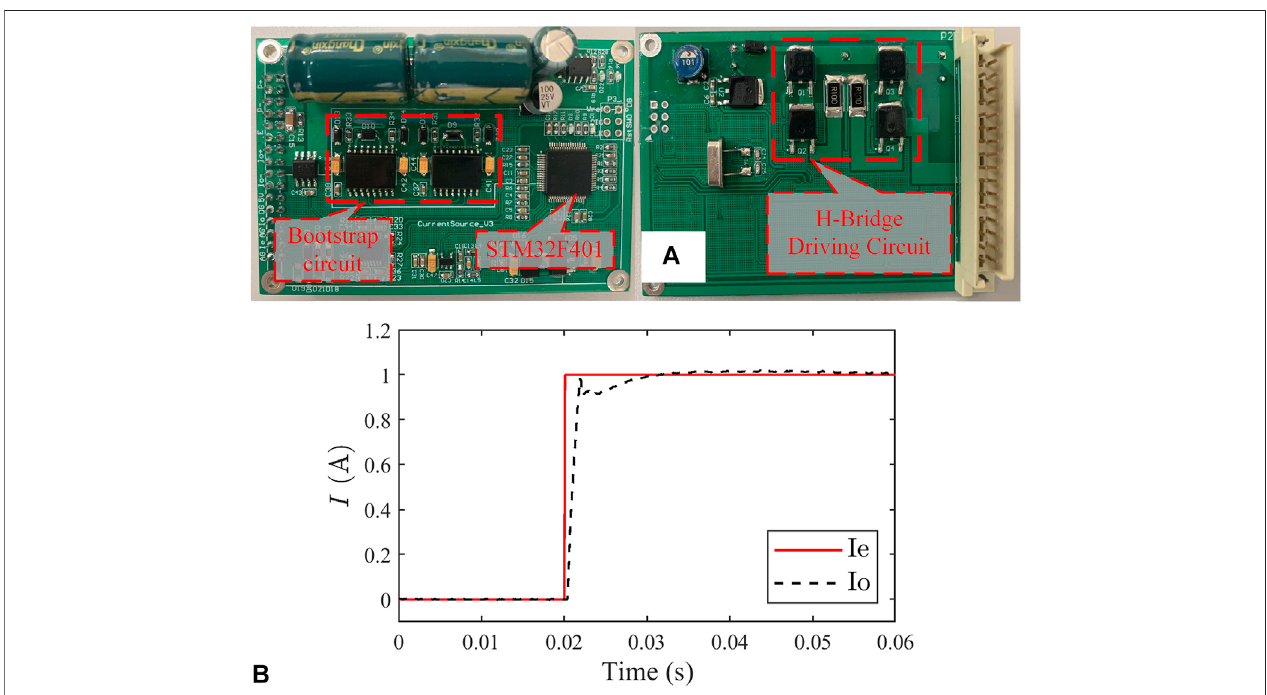
FIGURE 2 | Current driver: (A) PCB board; (B) step